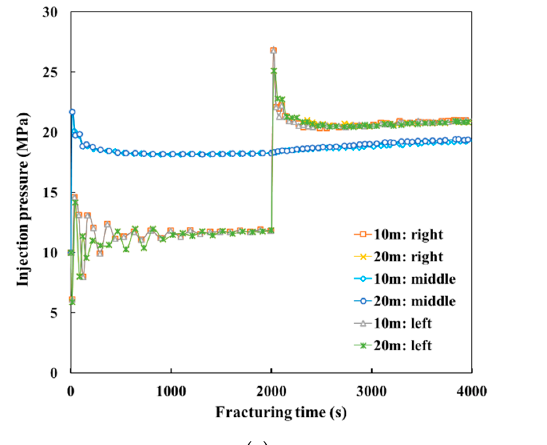
Figure 13. Fracture geometries of two-step and modified two-step fracturing with different closely- spacing (POR is the pore pressure: Pa): ( a ) Fracture geometries of two-step fracturing with spacing = 10 m; ( b ) Fracture geometries of two-step fracturing with spacing = 20 m; ( c ) Fracture geometries of modified two-step fracturing with spacing = 10 m; ( d ) Fracture geometries of modified two-step fracturing with spacing = 20 m.